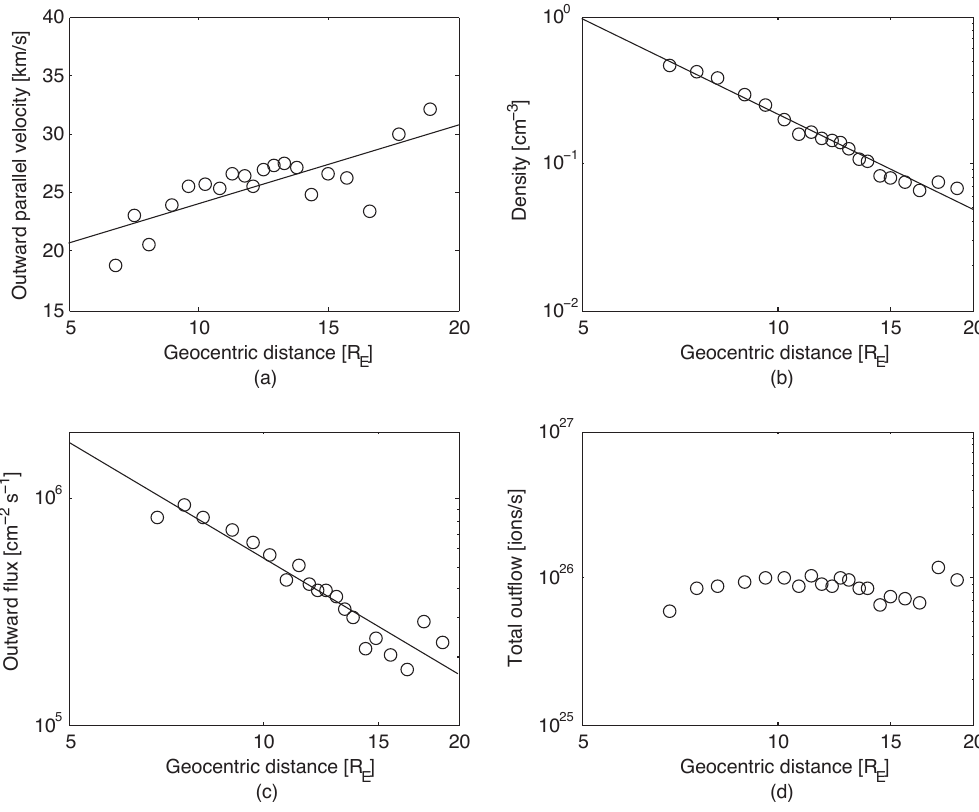
Fig. 6. Altitude dependence. Dependence on altitude of the outward parallel velocity (a) , the ion density (b) , the outward flux (c) , and the global outflow (d) . (The total data set consists of 180000